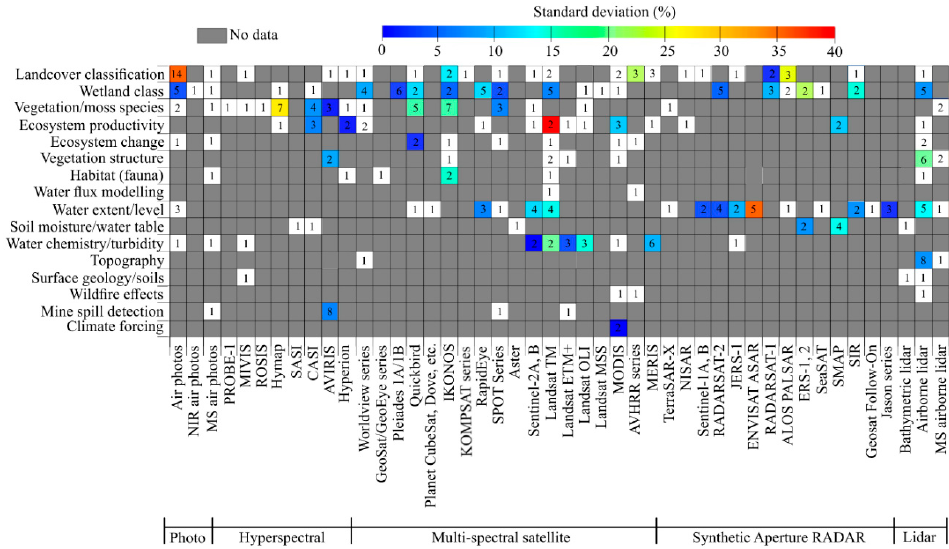
Figure 5. Standard deviation (SD) of the range of accuracies presented where the same remote sensing system was used for an application but differed in geographical area (presented by more than one article). Numbers within boxes represent the number (n) of observations per platform and application.